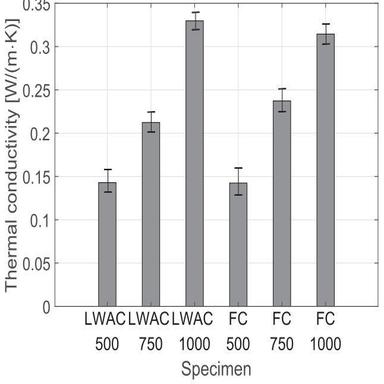
Thermal conductivity of LWC specimens.